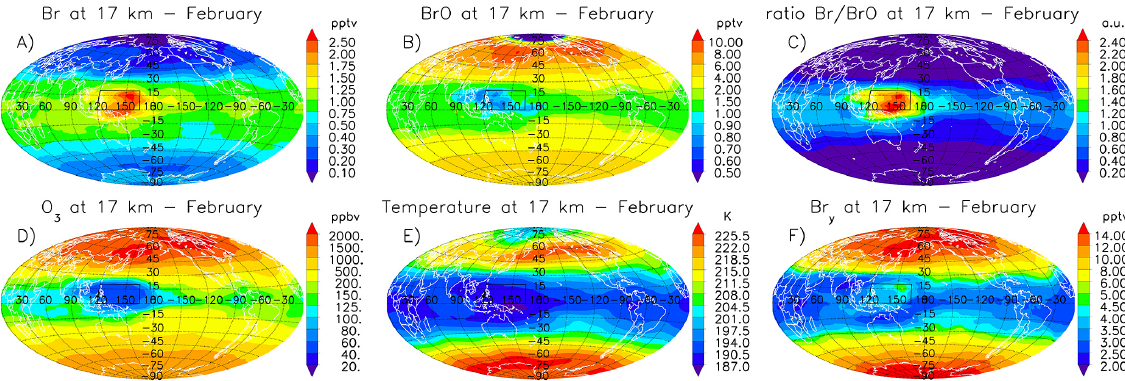
Figure 5. Average noontime geographical distribution of atmospheric bromine, ozone and temperature at 17km during February: (a) atomic Br; (b) BrO; (c) Br / BrO ratio; (d) ozone; (e) temperature; and (f) Br y . The location of the WP region, also considered to compute the vertical profiles of Figs. 2, 4, 10 and 11, is outlined in black.